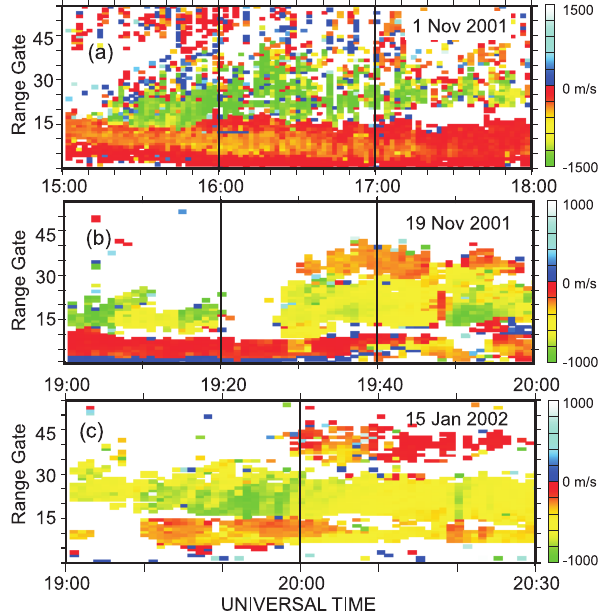
Fig. 4. Echo power, spectral width and velocity recorded by the Stokkseyri radar in the event of 1 November 2001 in range gates 0– 40. Red curves represent the median value of a respective parameter at various range